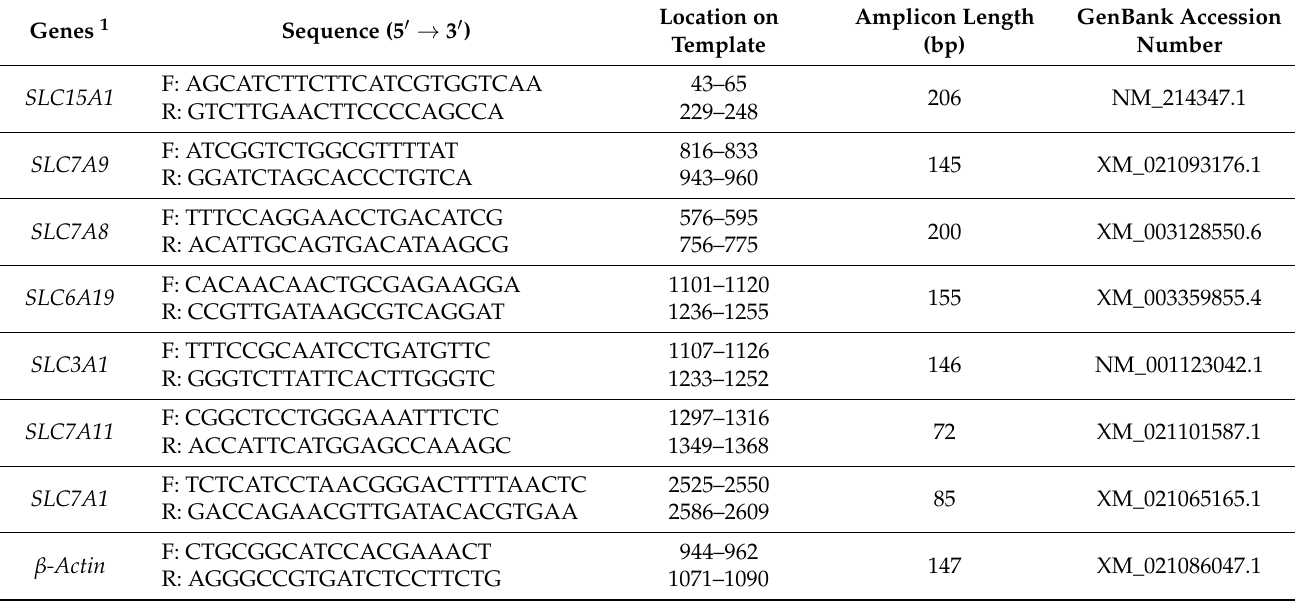
Table 2. Primer sequences, forward (F) and reverse (R), location on the template, amplicon size (bp), and GenBank accession numbers for both target and reference genes for reverse transcription-quantitative real-time polymerase chain reaction